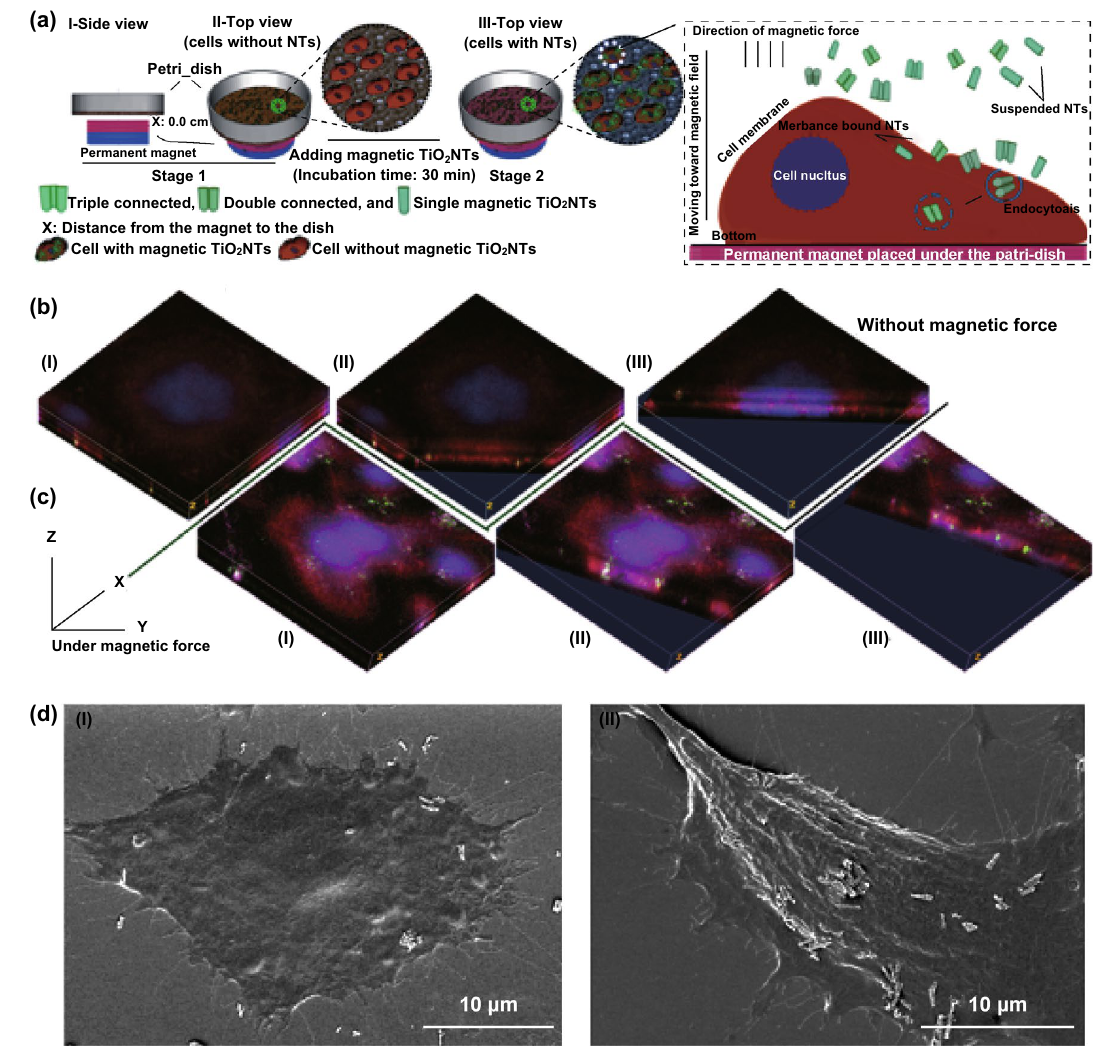
Fig. 5 a Illustration of the improved delivery of anticancer drug camptothecin‑loaded magnetic TiO 2 nanotubes under a magnetic force. Rep‑ resentative confocal microscopy images (3D) and SEM images of enhanced cellular uptake b without and c with a magnetic field. The confocal images show magnetic TiO 2 NTs (green), actin filament (red) and nucleus (blue). d Representative SEM micrographs of internalizing magnetic TiO 2 NTs without (I) and with (II) magnetic force. Adapted from Ref. [21] with permission from the Springer Nature. (Color figure